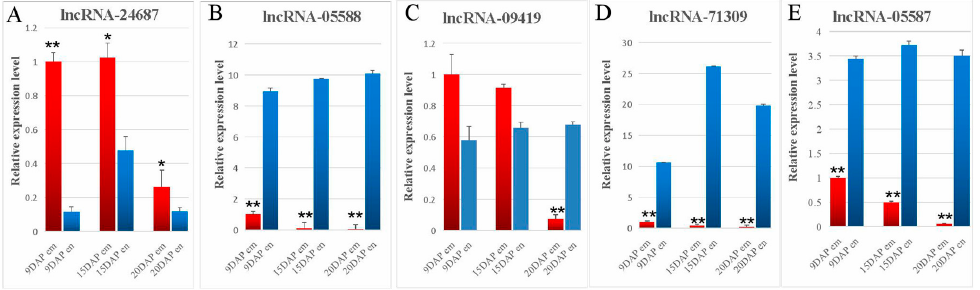
Figure 4. Validation of the differences in lncRNAs. To validate the differentially expressed lncRNAs identified by the RNA-seq results. qPCR was performed to test the expressions of one embryo-specific upregulated lncRNA, and four downregulated lncRNAs. Red bars and blue bars stand for tissues came from embryo and endosperm, respectively. The relative expression of the five differentially regulated lncRNAs normalized to ACTIN. The data in the figures represent the averages ± SD. * p < 0.05, ** p < 0.01, and *** p < 0.001 based on one-way